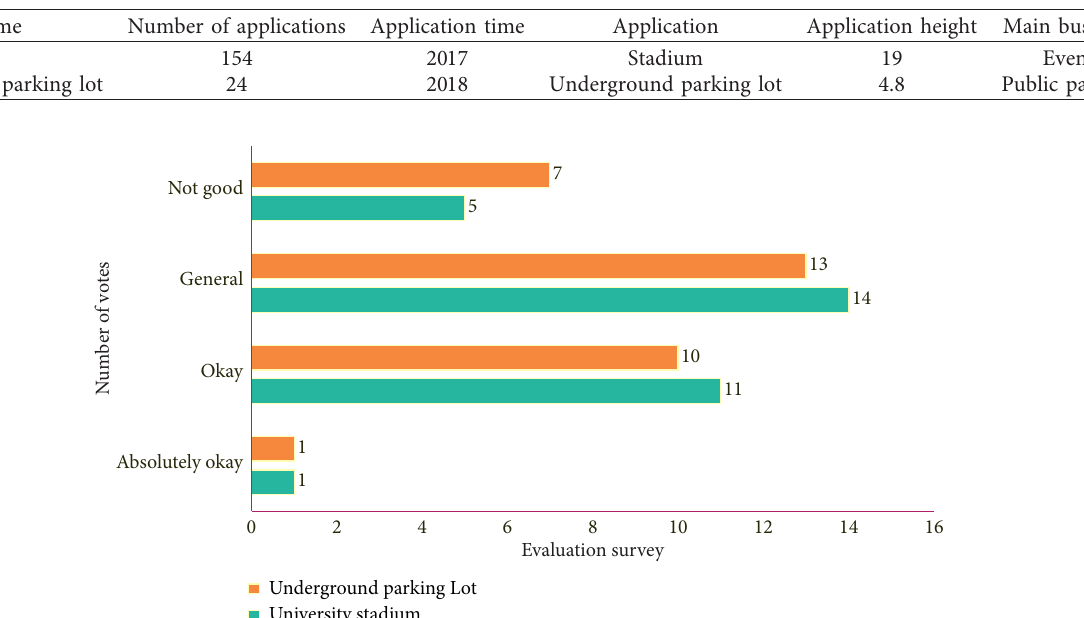
Table 2: Details of sample light pipe lighting project.